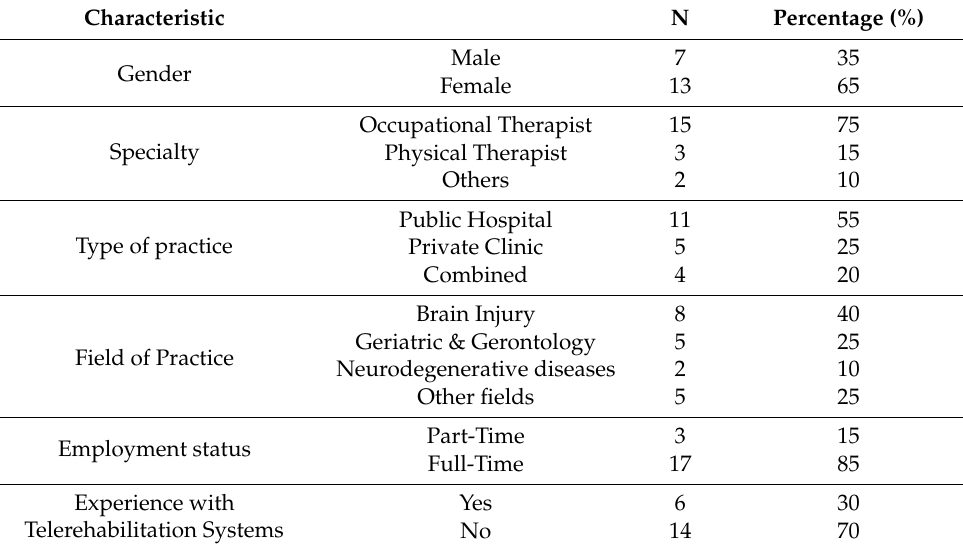
Table 5. Experts’